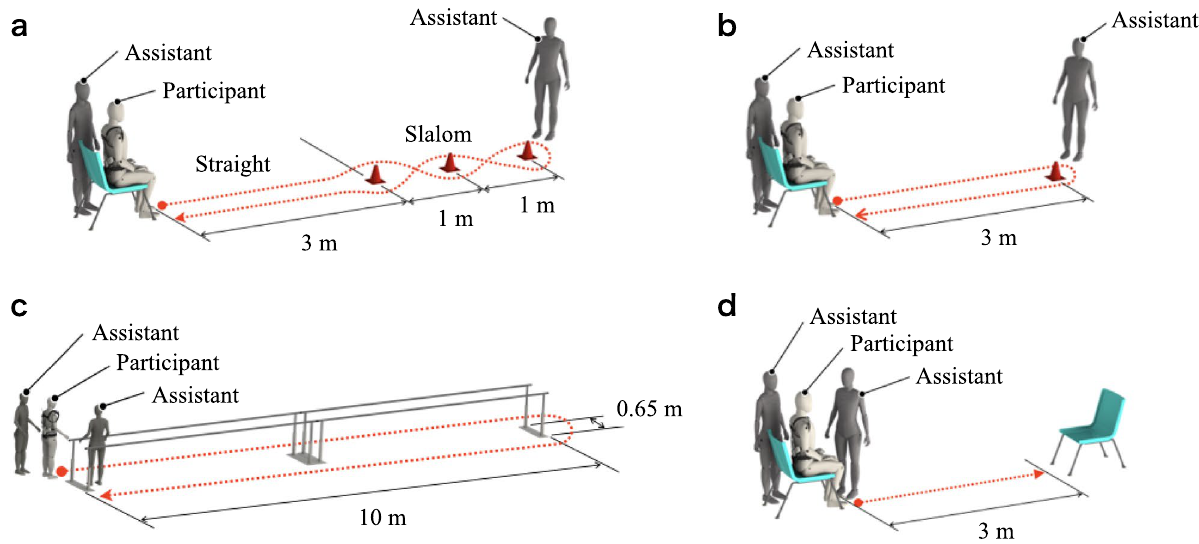
Figure 2. Experimental environments. ( a ) Slalom test, used to measure staggering behavior. ( b ) TUG test, used to measure mobility and balance. ( c ) U-shape test, used to measure festinating behavior. ( d ) The straight test, a simplified condition based on the TUG test. TUG, timed up and